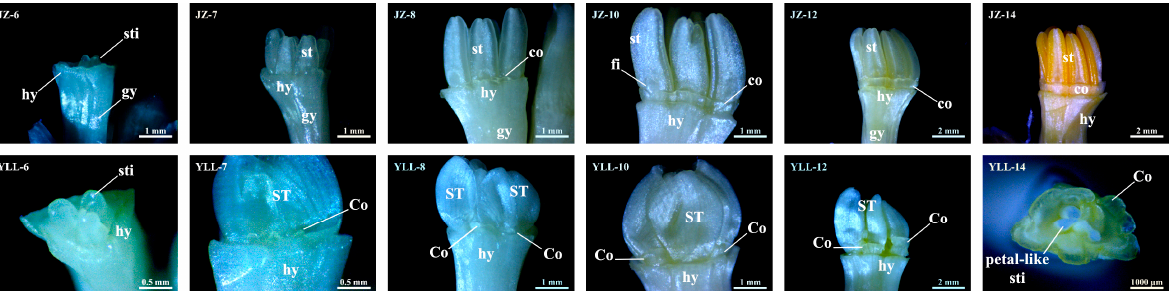
Figure 2. Images showing the corona differentiation of JZ and YLL by dissection with hands. JZ and YLL denote “Jinzhanyintai” and “Yulinglong”, respectively, and numeric characters represent sampling periods. For example, JZ-1 denotes the first observation for JZ in July 31. JZ-7 to JZ-14 and YLL-7 to YLL-12 represent tepals stripped for JZ and YLL in respective periods, JZ-6 represents the observation of tepals and stamens stripped for JZ in period 6, and YLL-6 and YLL-14 represent tepals and petal- like stamens stripped for YLL in periods 6 and 14, respectively. hy—hypanthium;